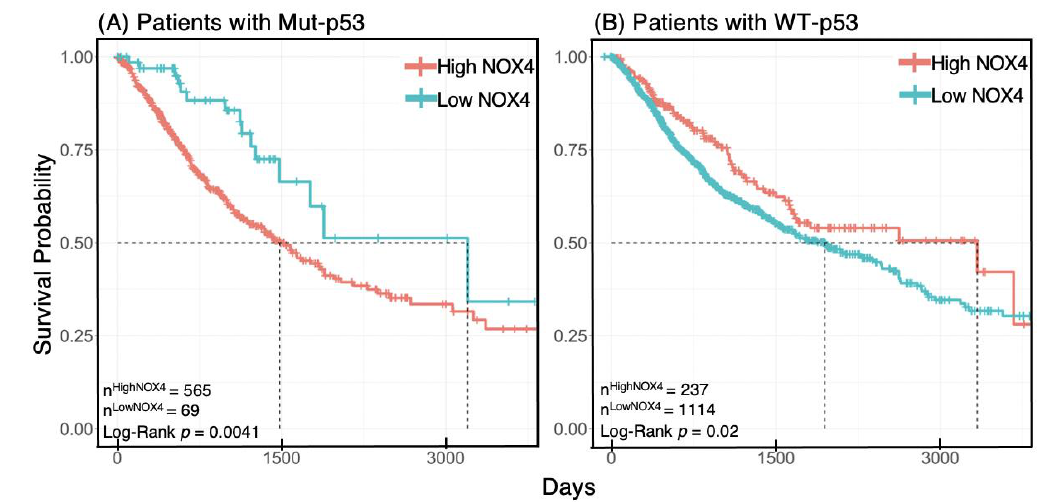
Figure 7. Increased NOX4 mRNA is deleterious to survival in the presence of mut-p53. Patients in the Final Pan-Cancer Dataset were identified as harboring a mutated form of TP53 ( A ) or WT- TP53 ( B ). Optimized cut-off points were then calculated for high vs. low NOX4 mRNA levels for each group and Kaplan–Meier plots and Log-rank tests were used to estimate survival probability and p -values, respectively. Ten-year survival (3650 days) is shown in both ( A ) and ( B ).